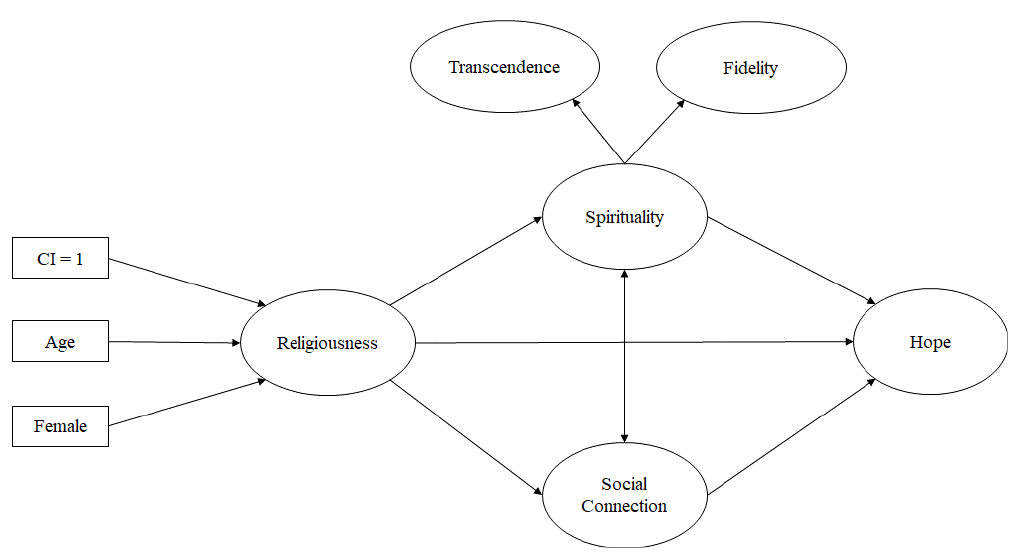
Figure 1. Hypothesized model.